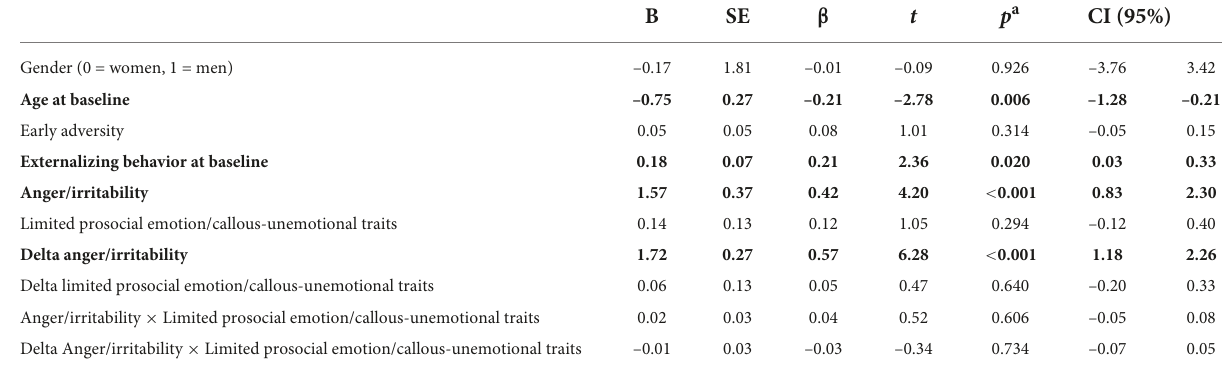
TABLE 4 Prediction of externalizing behaviors at follow-up.